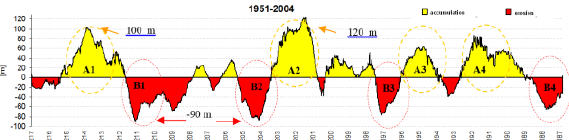
Figure 1. Changes in location of front dune base lines in the time period of